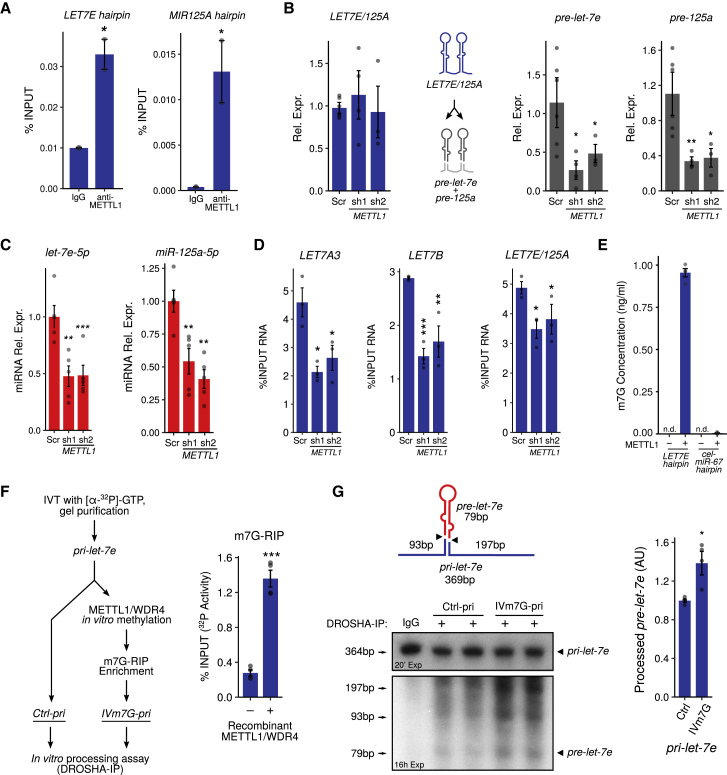
METTL1 Directly Modifies let-7e pri-miRNA and Regulates Its Processing(A) CLIP-qPCR using a METTL1-specific antibody or a non-specific IgG. The levels of immunoprecipitated pri-let-7e and pri-mir-125a hairpins are shown. The average of two independent immunoprecipitation reactions ± SEMs is shown (∗p < 0.05, two-tailed t test). miR-148a is shown in Figure S4E as a negative control.(B) qRT-PCR showing the levels of either LET7E/125A primary transcript (blue) or let-7e and miR-125a precursors (gray) upon METTL1 knockdown in A549 cells. The average of five to six independent biological replicates ± SDs is shown (∗p < 0.05, ∗∗p < 0.01, two-tailed t test).(C) qRT-PCR quantification of let-7e-5p and miR-125a-5p upon METTL1 knockdown. The average of five independent biological replicates ± SDs is shown (∗∗p < 0.01, ∗∗∗p < 0.001, two-tailed t test). miR-148a-3p is shown in Figure S4F as a negative control.(D) m7G RNA immunoprecipitation and qRT-PCR of LET7A3, LET7B, and LET7E/125A primary transcripts in A549 cells upon METTL1 knockdown. The average of three independent biological replicates ± SEMs is shown (∗p < 0.05, ∗∗p < 0.01, ∗∗∗p < 0.001, two-tailed t test).(E) In vitro methylation reaction using recombinant METTL1/WDR4 pre-assembled complex on let-7e or cel-miR-67 primary hairpin (negative control). MS analysis shows specific m7G methylation of the let-7e hairpin. The average of three independent experiments ± SDs is shown.(F) Experimental strategy to obtain radiolabeled, m7G-modified pri-let-7e (IVm7G-pri). The histogram shows the fraction of RNA recovered by m7G-RIP after in vitro methylation with METTL1/WDR4, as evaluated by scintillation counting (∗∗∗p < 0.001, two-tailed t test).(G) In vitro processing assay of pri-let-7e: control (Ctrl) or in vitro methylated pri-miRNAs were incubated in the presence of immunoprecipitated DROSHA. Autoradiography reveals that IVm7G-pri undergoes more efficient processing, yielding the expected cleavage pattern shown in the illustration. The histogram shows the relative quantification of the resulting pre-let-7e from four samples obtained in two independent experiments (∗p < 0.05, two-tailed t test). Autoradiography images are composites of different molecular weight regions and exposure times. Full, unprocessed images are deposited on Mendeley Data.See also Figure S5.